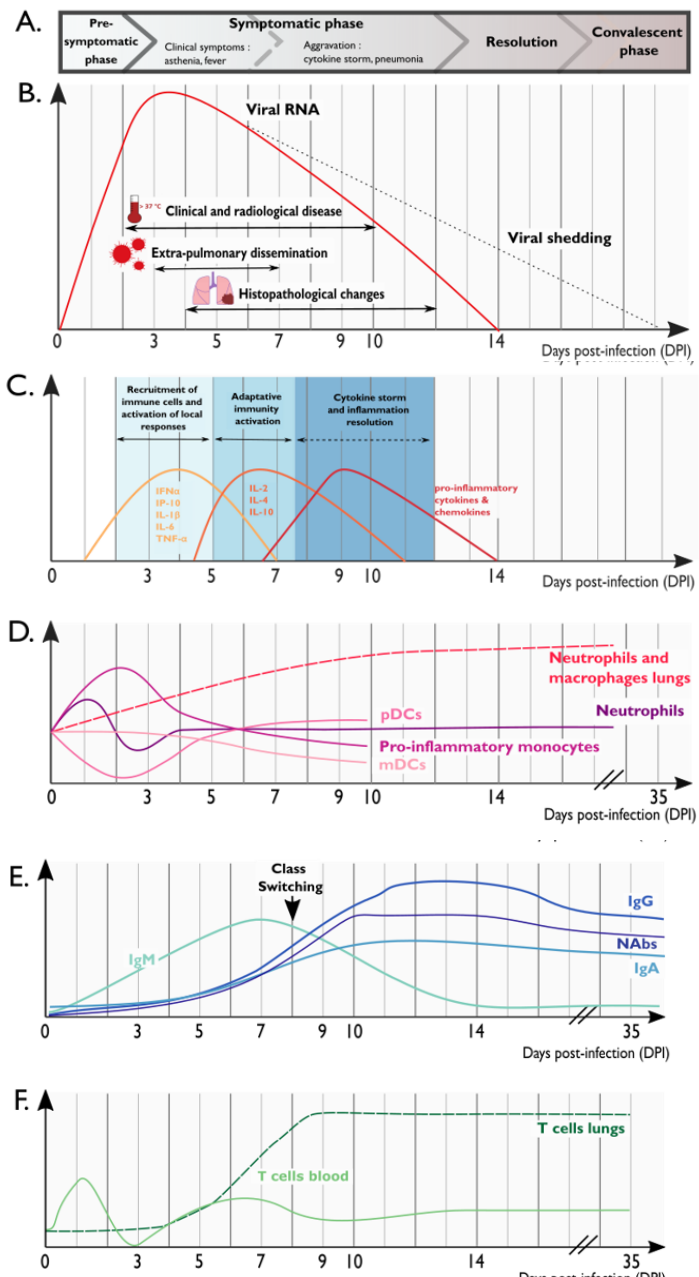
Figure 1. Schematic representation of the clinical, virologic and immunologic features observed over the course of SARS-CoV-2 infection in NHPs. ( A ) Clinical correlates of SARS-CoV-2 infection in NHPs. ( B ) SARS-CoV-2 viral kinetics and histopathological changes in the lungs of NHPs. ( C ) Cytokine production in the lungs of SARS-CoV-2 infected NHPs. ( D ) Dynamics of innate immune cells in the blood (solid lines) and in the lungs (dashed line). ( E ) Dynamics of virus-specific anti-bodies. ( F ) Dynamics of virus-specific T cells in the blood (solid line) and in the lungs (dashed line). Similar dynamics are observed in SARS-CoV-2 infected individuals. Figure was generated using Inkscape.